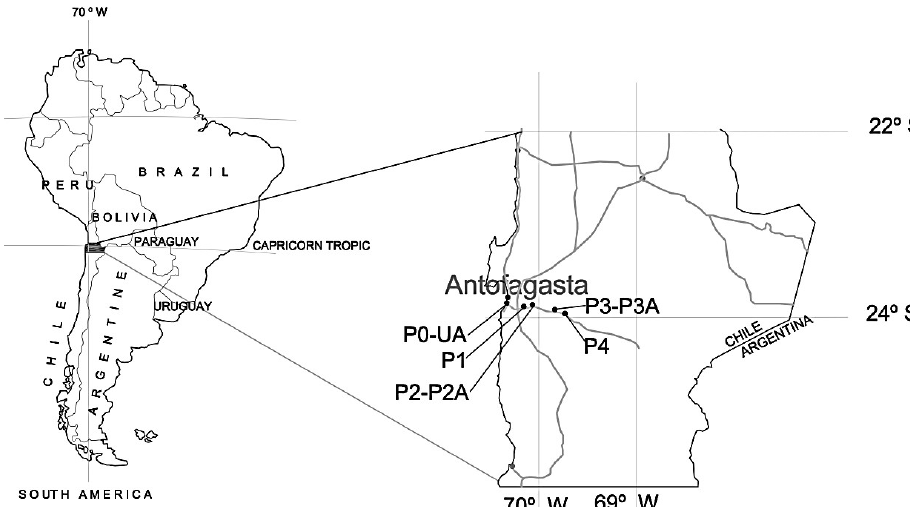
Figure 1. Map of experimental sites.